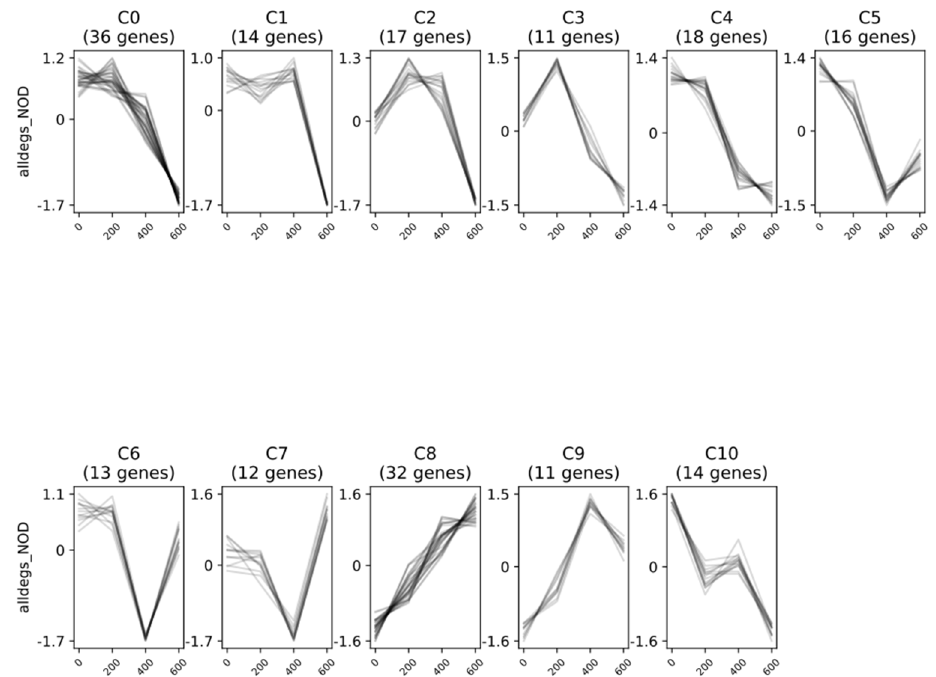
Figure 5. Pattern of expression of differentially expressed genes (DEGs) in Casuarina glauca nodulated by nitrogen-fixing Frankia casuarinae Thr (NOD + ), grouped by predicted co-expressed gene clusters. Clustering analysis was performed by Clust tool, with normalized reads from samples grown at 0, 200, 400, and 600 mM NaCl.